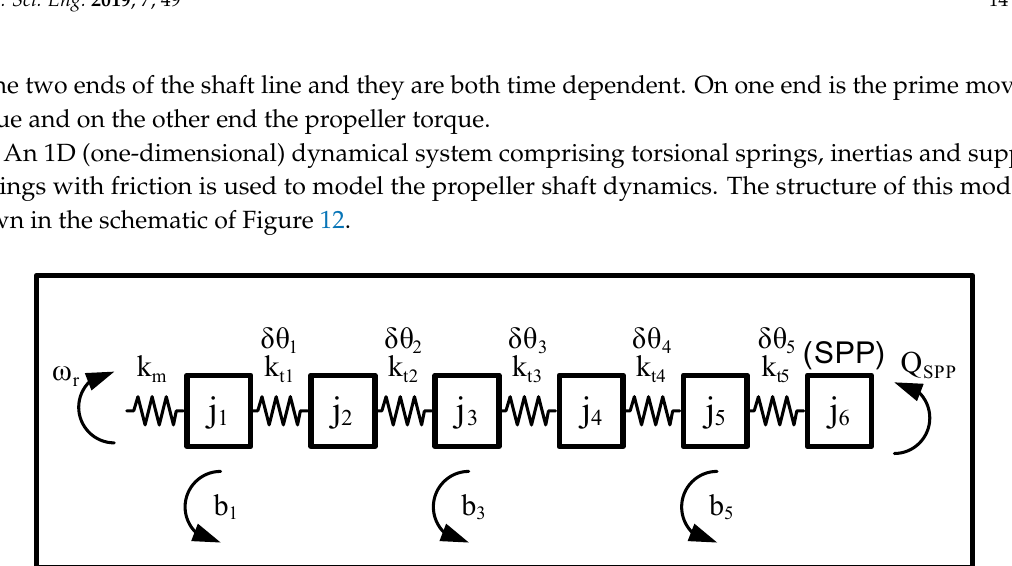
Table 6. Propulsion shaft